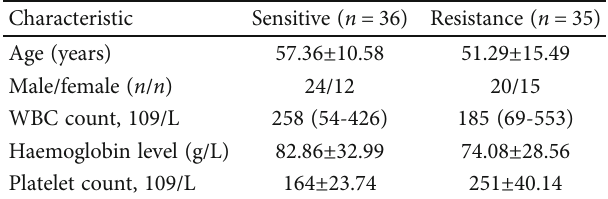
Table 1: Characteristics of CML patients included in the